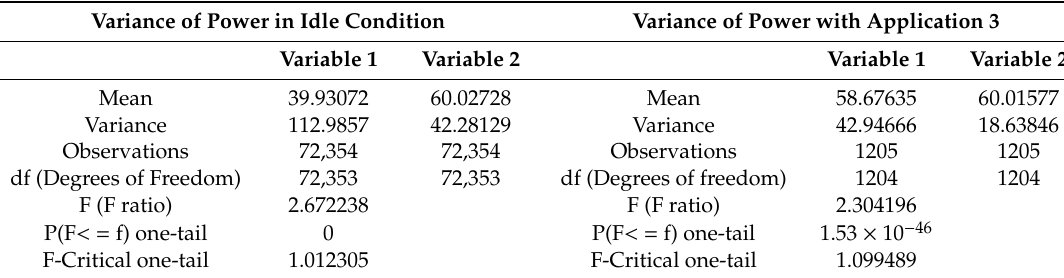
Table 4. F-Test of two samples of variance.